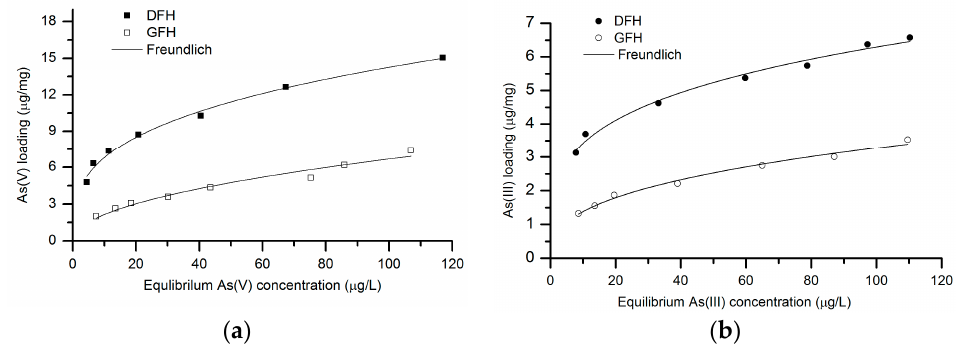
Figure 2. ( a ) As(V) and ( b ) As(III) adsorption isotherms for DFH and GFH materials in DI water. Solid lines represent the Freundlich model using non-linear fitting. Experimental conditions: Initial (As(V)) 190 µg/L, initial (As(III)) 190 µg/L, equilibrium pH value 7.9 ± 0.1 and temperature 20 °C.